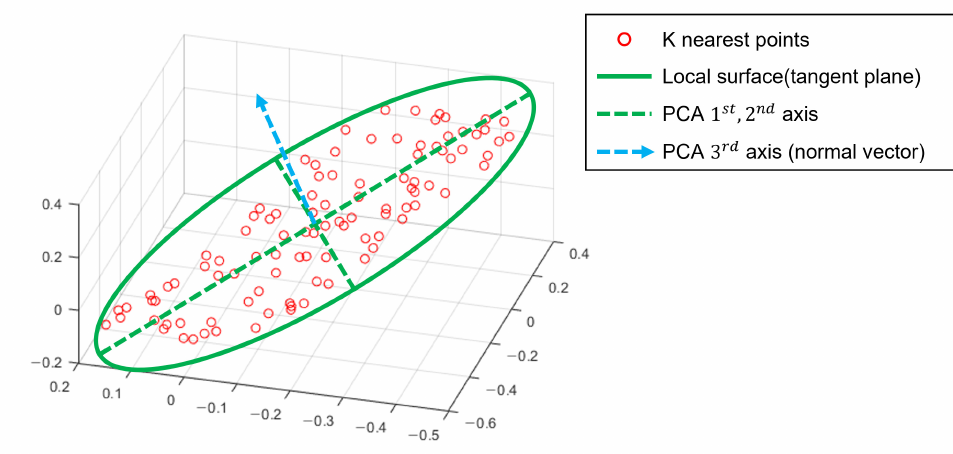
Figure 3. Conceptual image of PCA-based local surface extraction. In a 3D space, the normal vector of the plane is the 3rd eigenvector of the PCA